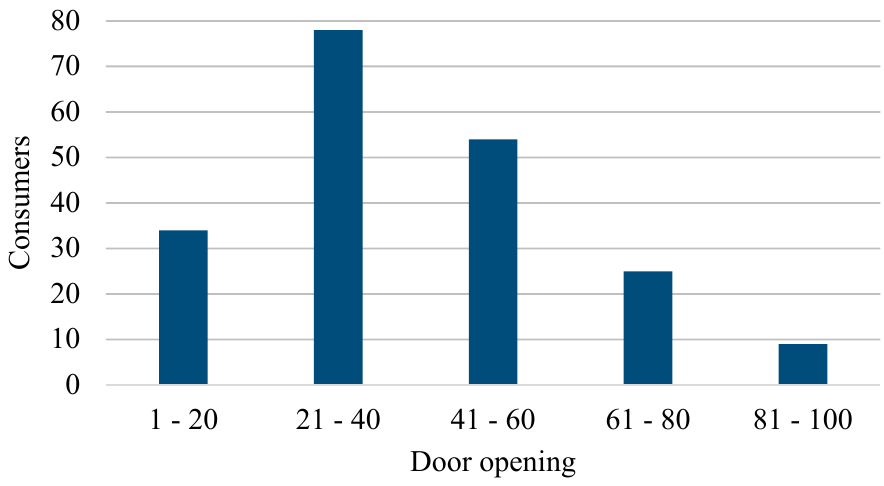
Figure 5. Door opening frequency ranges in the food compartments.